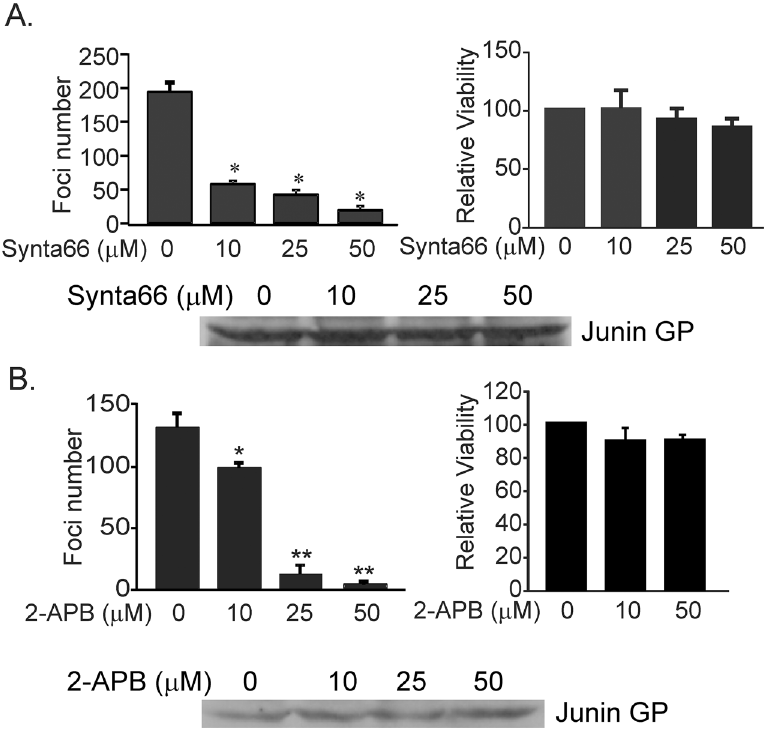
Fig 5. Synta66 and 2-APB inhibit egress of live JUNV (Candid-1 strain) from VeroE6 cells. JUNV foci were visualized and the number of all detectable foci was plotted for each Synta66 (A) or 2-APB concentration (B) . Statistical significance was analyzed by one way ANOVA ( * p < 0.01 for Synta66) ( * p < 0.05, ** p < 0.01 for 2-APB). MTT based cell viability measurements demonstrate no toxicity of Synta66 (A) or 2-APB (B) under identical conditions as those used for JUNV infection of VeroE6 cells. Each value is normalized to cells treated with DMSO alone. Comparable levels of JUNV GP were detected by immunoblot analysis in JUNV infected VeroE6 cells in the absence (DMSO alone) or presence of Synta66 (A) or 2-APB (B)